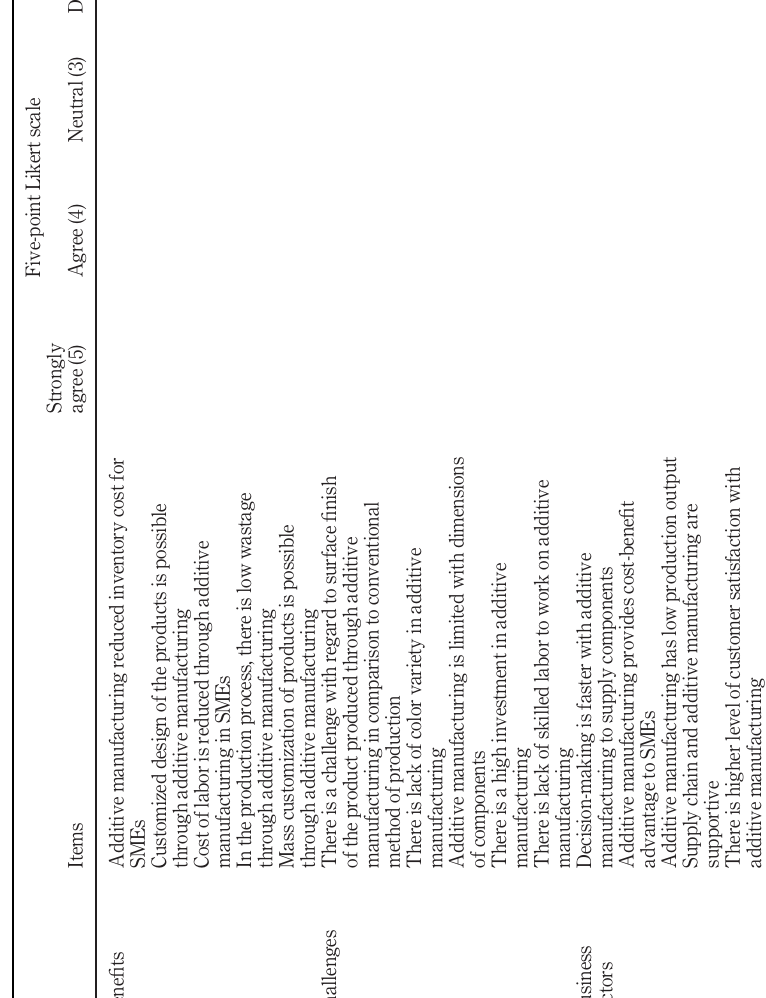
Table A1. Questionnaire for the